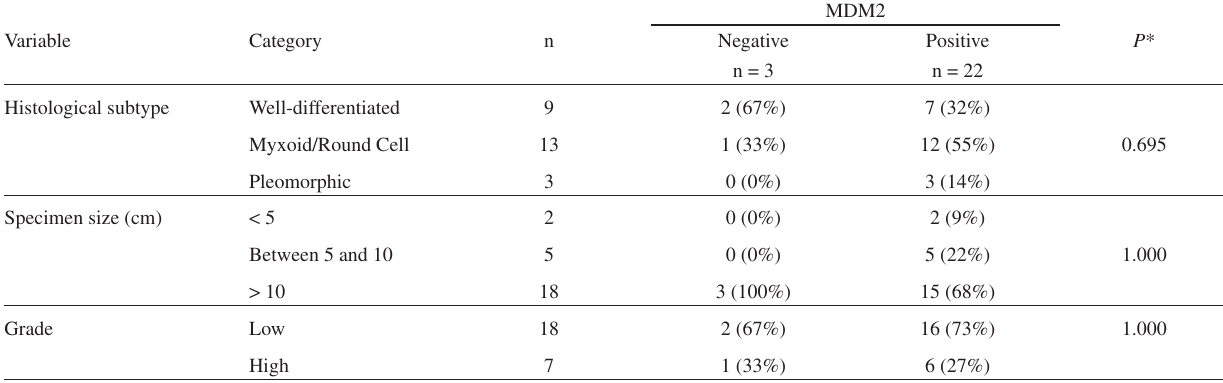
Table 3 - Study of the correlation between the immunohistochemical evidence of MDM2 expression and the anatomical and pathological variables in the 25 patients with primary liposarcoma of the extremities